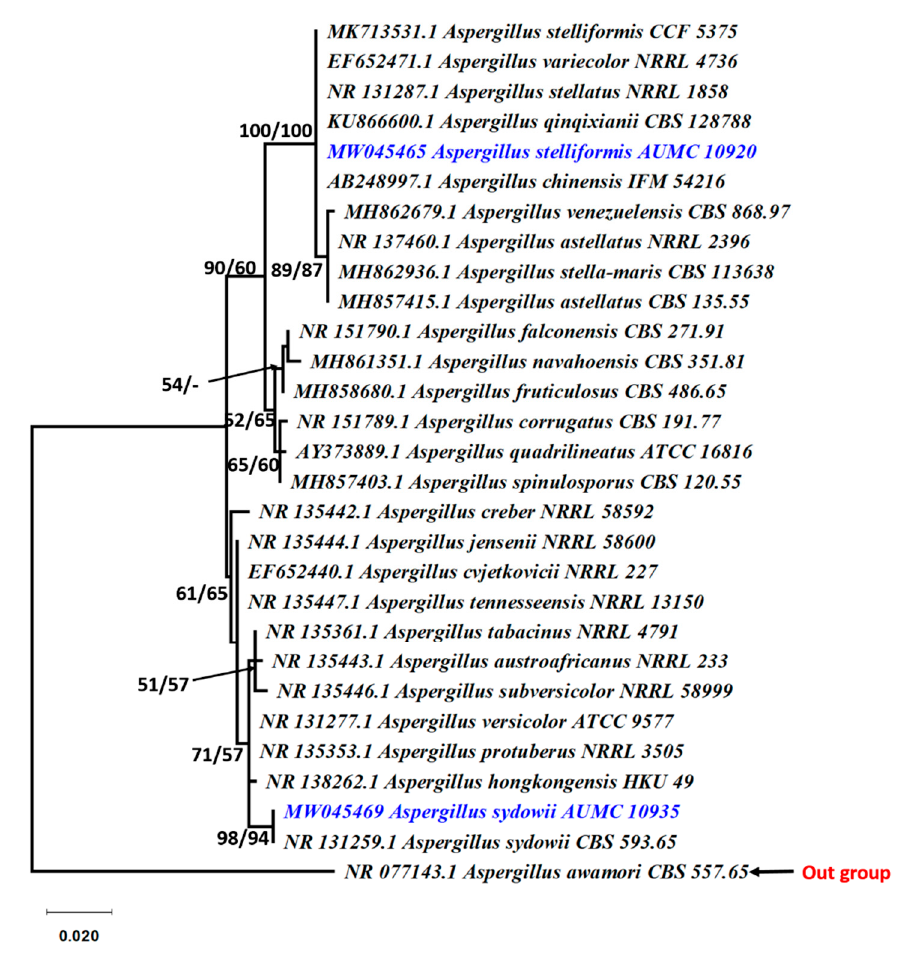
Figure 2. Phylogenetic tree generated from MP analysis based on ITS sequence data of Aspergillus stelliformis AUMC 10920 and A. sydowii AUMC 10935 associated to other related genes in Aspergillaceae. Blue color refers to the species in this study. Bootstrap support values (100 replications) for ML/MP combination equal to or greater than 50% are indicated at the respective nodes. The tree is rooted to Aspergillus awamori -CBS 557.65 as the out group.